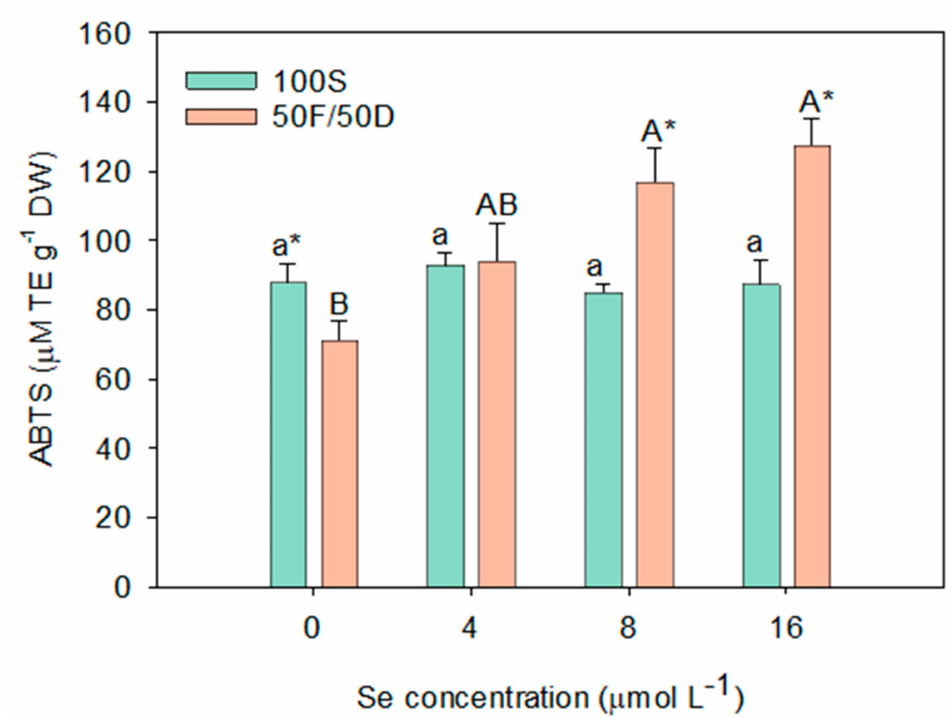
Figure 4. Effects of different selenium concentration (0, 4, 8, and 16 µ moles L − 1 ) and two types of irrigation water (100S or 50F/50D) on antioxidant activity (ABTS+*) in lettuce. The data are presented as the treatment means ( n = 6). Different lower-case letters indicate significant ( p ≤ 0.05) differences between different dosages of selenium combined with the 100S treatment and different capital letters indicate significant ( p ≤ 0.05) differences between different dosages of selenium combined with the 50F/50D treatment. * denotes significant differences ( p ≤ 0.05) between plants submitted to 100S treatment and those irrigated with 50F/50D for the same Se